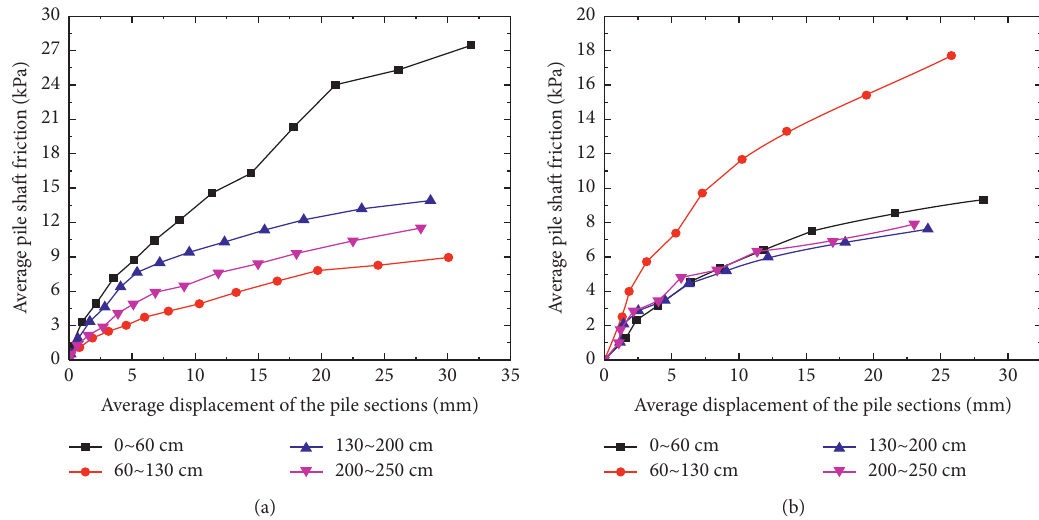
Figure 11: The average pile shaft friction resistance versus the average displacement of the pile sections. (a) LCPF. (b) HCPF.